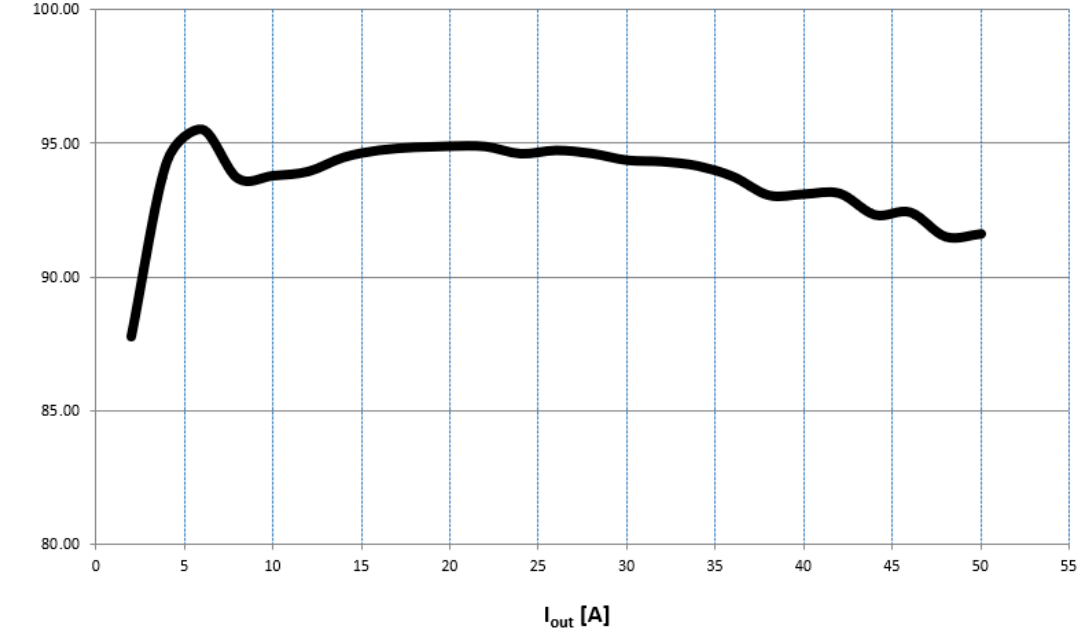
Figure 7. Efficiency at 500 kHz over current load.